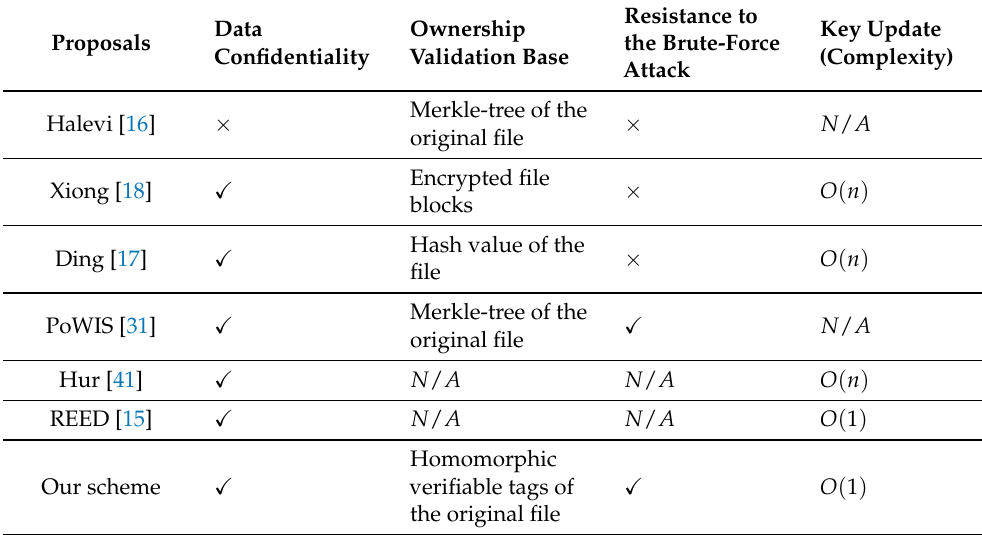
Table 1. Comparison with other deduplication schemes. (Hur [41] and REED [15] are server-side deduplication schemes which do not include the PoW